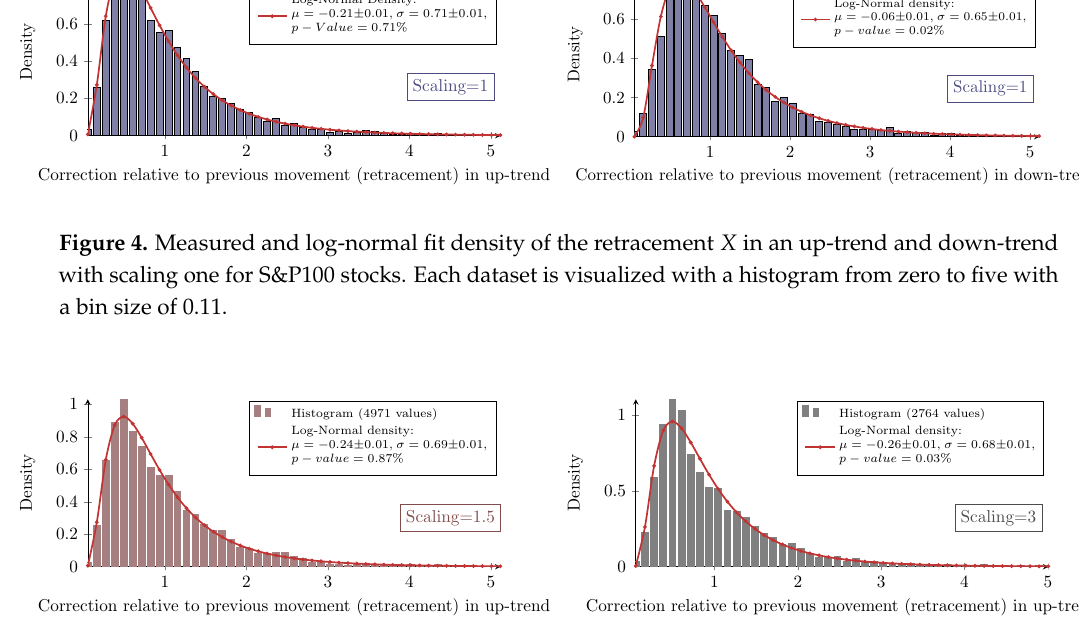
Figure 5. Measured and log-normal fit density of the retracement X in an up-trend with scaling 1.5 and three for S&P100 stocks. Each dataset is visualized with a histogram from zero to five with a bin size of